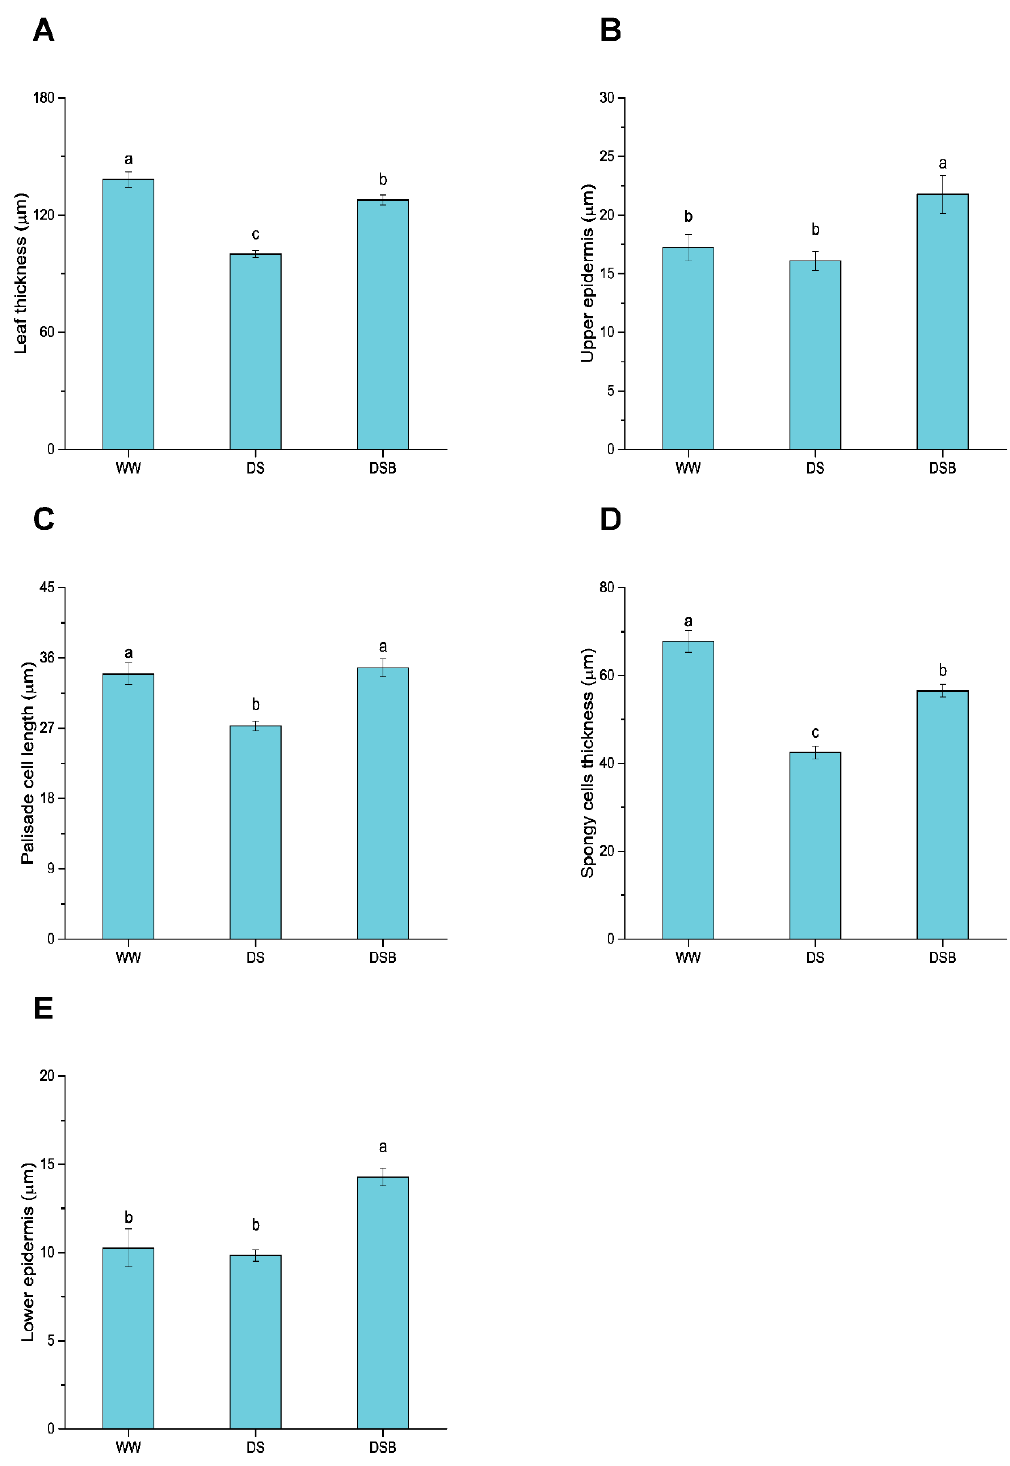
Figure 2. Leaf structure is regulated by 2,4-epibrassinolide (EBR) application under drought stress. This figure displays the total leaf thickness ( A ), upper epidermis thickness ( B ), palisade cells length ( C ), spongy tissue thickness ( D ), and lower epidermis thickness ( E ). The data are presented as means ± SE in the three treatments including WW (well-watered), DS (drought stress), and DSB (drought stress + 0.05 mM EBR application). Error bars represent SE of the mean. Different letters on bars show significant differences at p < 0.05 using the LSD test.